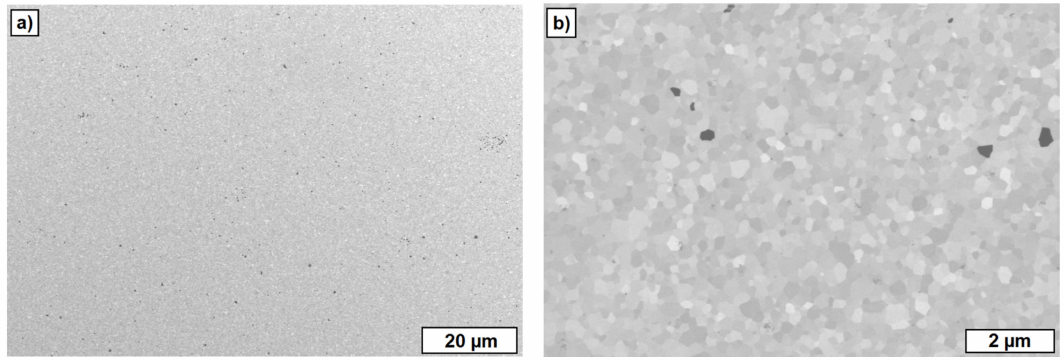
Figure 15. FESEM images of sintered zirconia test components additively manufactured by T3DP with 36 vol.-% zirconia particles and without PFA in the suspension. ( a ) Overview; ( b )